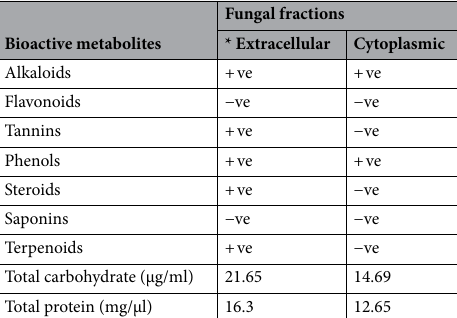
Table 2. Screening study to detect the produced phytochemical metabolites into endophytic Trichoderma virens strain EG92 fractions which cultivated using Wheat bran medium. *Denotes the effective cellular compartment (extracellular fraction) that was used to maximise the mass weight of the MnO